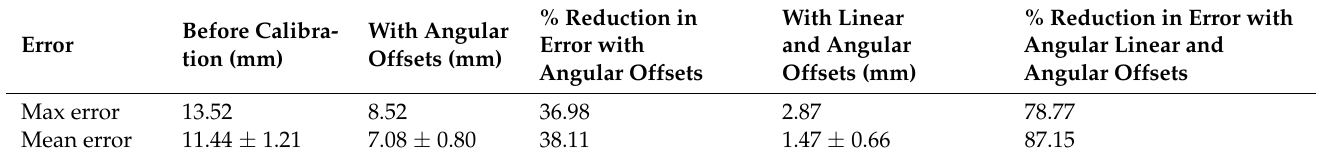
Table 11. Resultant position error before and after calibration.